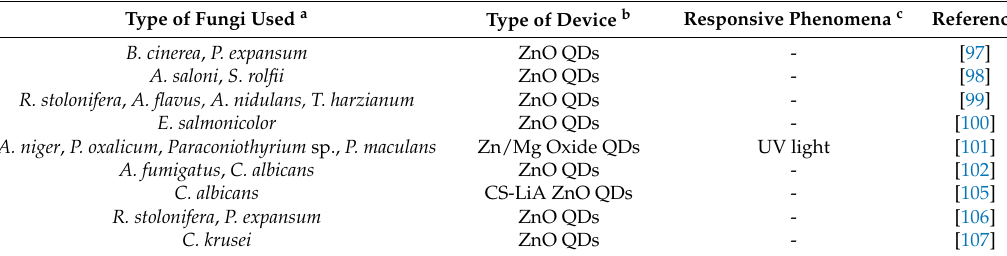
Table 3. ZnO nanoplatforms for antifungal